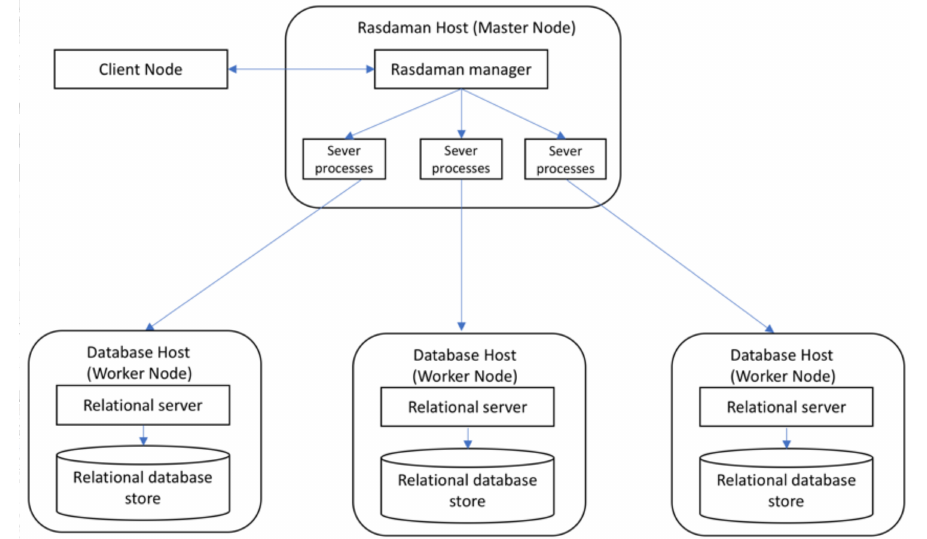
Figure 4. The architecture of